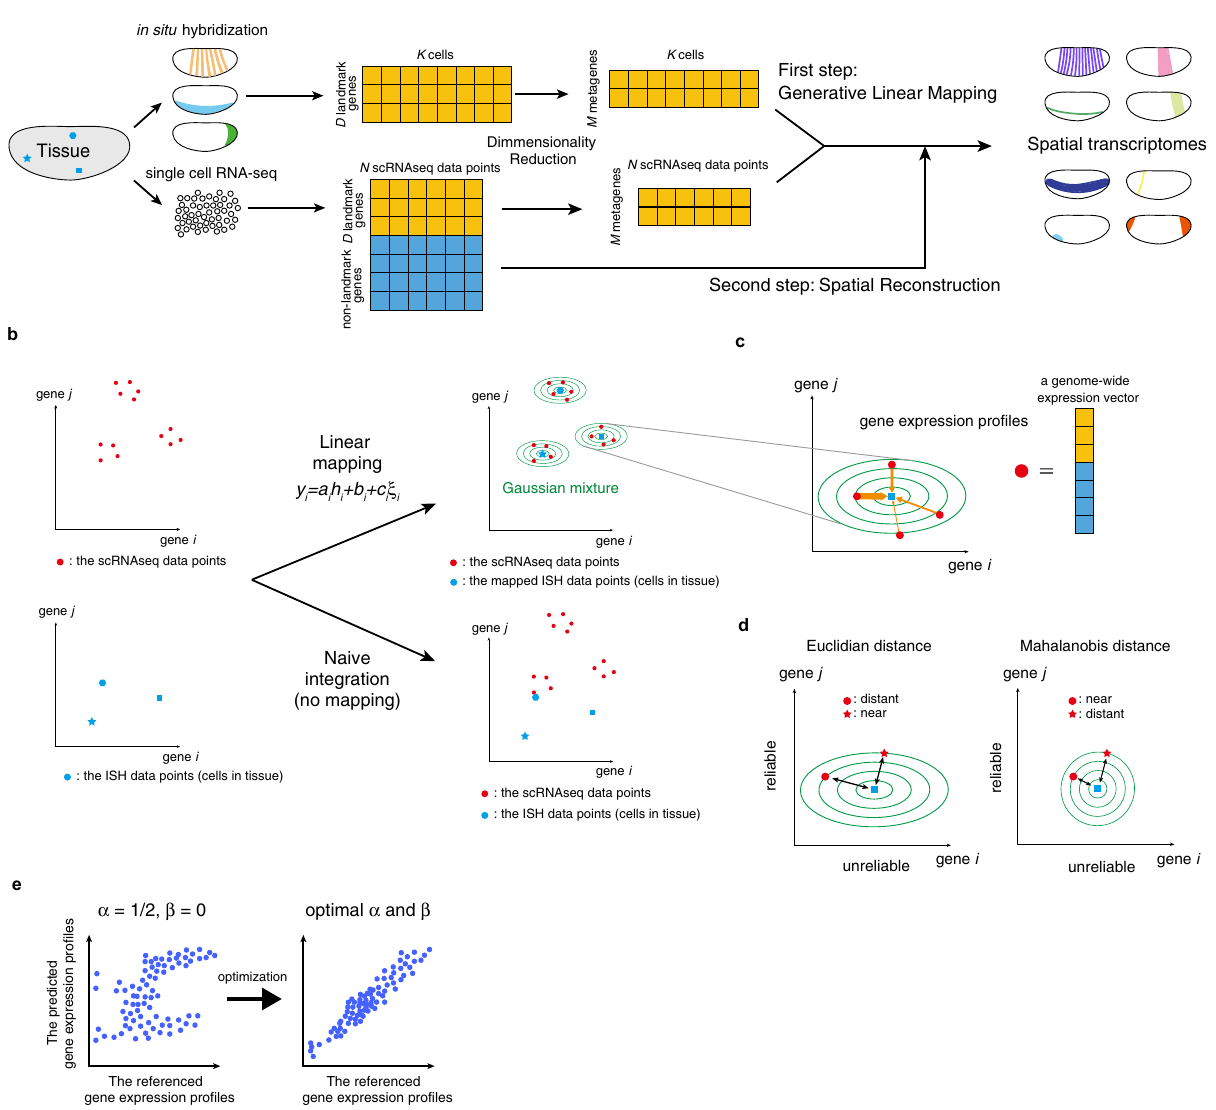
Fig. 1 Schematic illustration of Perler. a Flow of data processing. b Generative linear mapping from ISH data to the scRNA-seq space. The left and right panels indicate scatter plots in high-dimensional ISH and scRNA-seq spaces. Because ISH data points did not match scRNA-seq data points (naive integration) in the absence of mapping, ISH data points were mapped in order to fi t the scRNA-seq data points the best using the EM algorithm. Blue points indicate ISH data points, red points indicate scRNA-seq data points, and green lines indicate contours of the estimated multivariate Gaussian distribution (see “ Methods ” ). c Reconstruction/prediction of gene expression by Mahalanobis ’ metric-based weighting (see “ Methods ” ). Orange arrows indicate weights between scRNA-seq data points to cell k , and their widths re fl ect the Mahalanobis ’ metric-based weights. d Schematic demonstrating the difference between Euclidian and Mahalanobis distance. The expression levels of gene i are not reliable as this gene has high noise intensity, while gene j has low noise intensity, thus, its expression levels are considered reliable. In the Mahalanobis distance, the expression levels of each gene are considered by a variance scale. Note, although the “ star ” scRNA-seq data point is nearer to the ISH data point than the “ circle ” scRNA-seq data point in Euclidian distance, the weight of the “‘ star ” data point is smaller than that of the “ circle ” point. e Weight determination. The hyperparameters of the weighting function, α and β , are determined by cross-validation to ensure that the referenced gene-expression pro fi les correlate well with the predicted gene- expression pro fi les (see “ Methods ” ). Dots correspond to cells in tissue. The left and right panels indicate the conceptual scatter plots of the expression levels of the genes before ( α = 1/2, β = 0) and after parameter optimization, patterns, which can lead to biased parameter estimation and the metagene-expression level i (i.e., factor i ) in the scRNA-seq cause a loss of mapping ability. To reduce redundancy in scRNA- and ISH spaces as y i and h i in the equation above (see “ Methods ” ). seq and ISH data, we performed dimensionality reduction using partial least squares correlation analysis (PLSC) 19 (see “ Methods ” ). Each factor in the reduced dimension can be interpreted as a “ metagene ” , which is representative among a Model-based mapping between scRNA-seq and ISH data . highly correlated gene cluster, with its coordinate corresponding Previously, Karaiskos et al. 5 measured gene expression in indi- to the expression level of the metagene. In Perler, we regarded vidual cells dissociated from early D. melanogaster embryos at